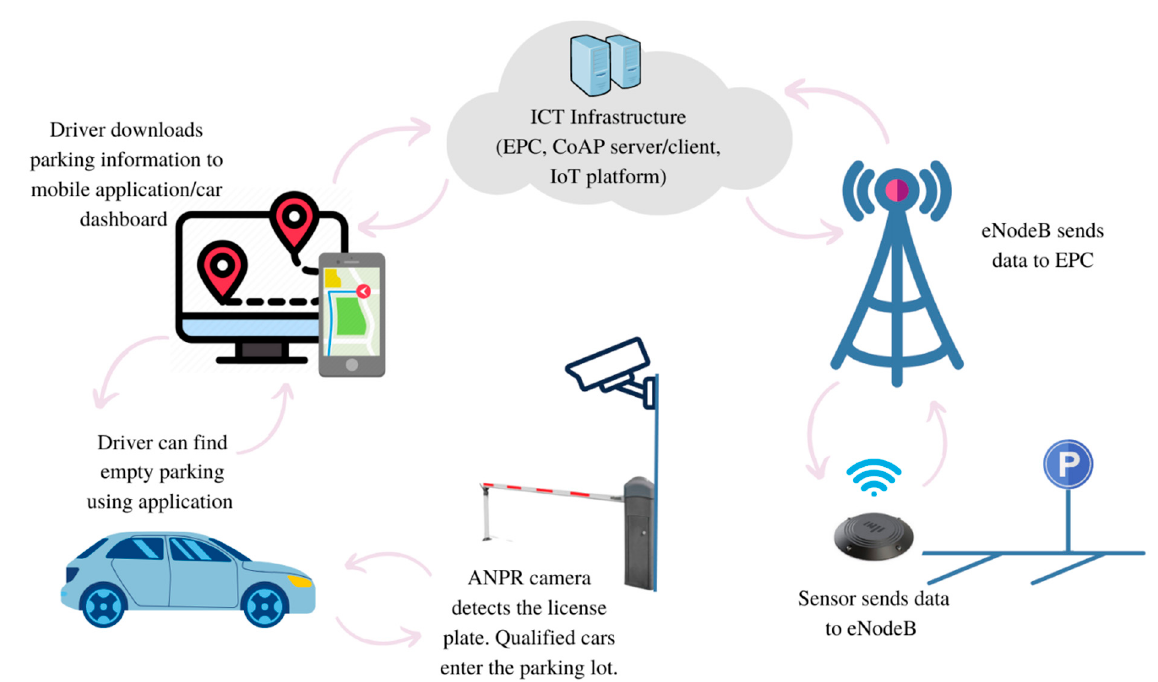
Figure 18. A scenario involving the use of the proposed solution for smart parking.